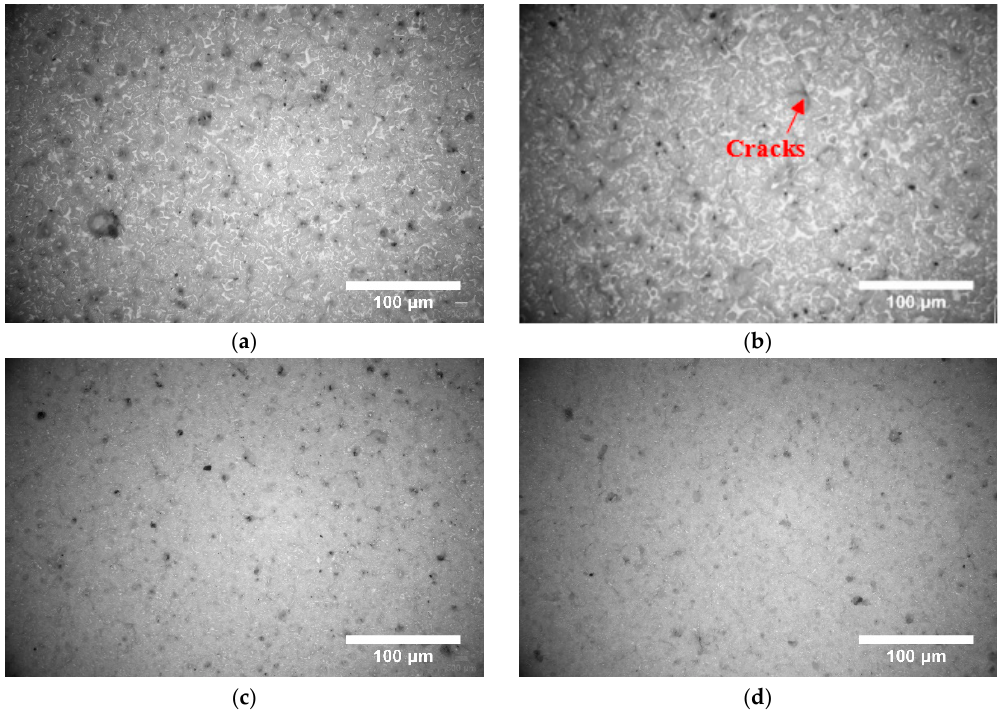
Figure 6. Surface morphology of the different coating samples after sintering taken by CCD camera: ( a ) Sample 1 (1:1:2); ( b ) Sample 2 (1:2:2); ( c ) Sample 3 (1:1:1); and ( d ) Sample 4 (1:2:1).